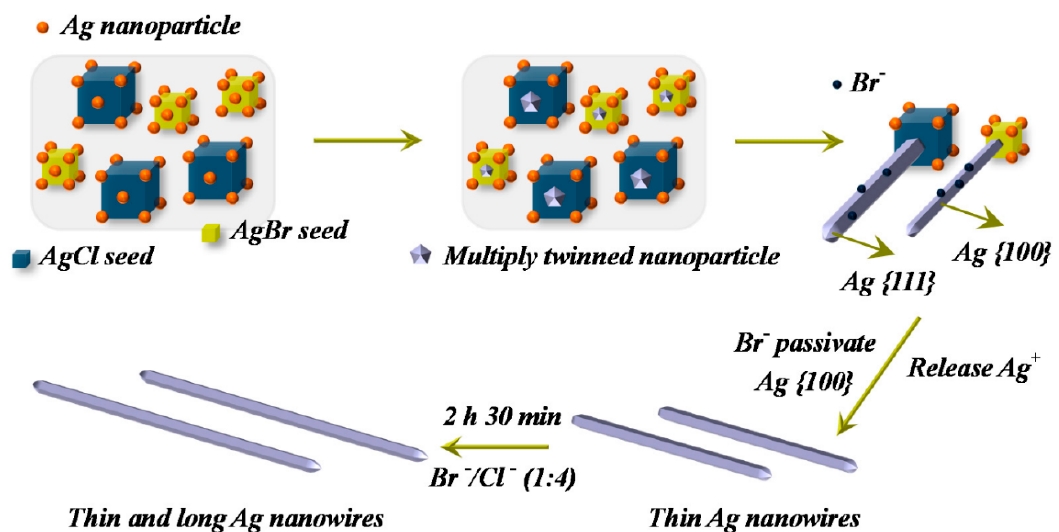
Figure 2. Growth mechanism of AgNWs via chemical reduction process. Reproduced from Ref. [27]